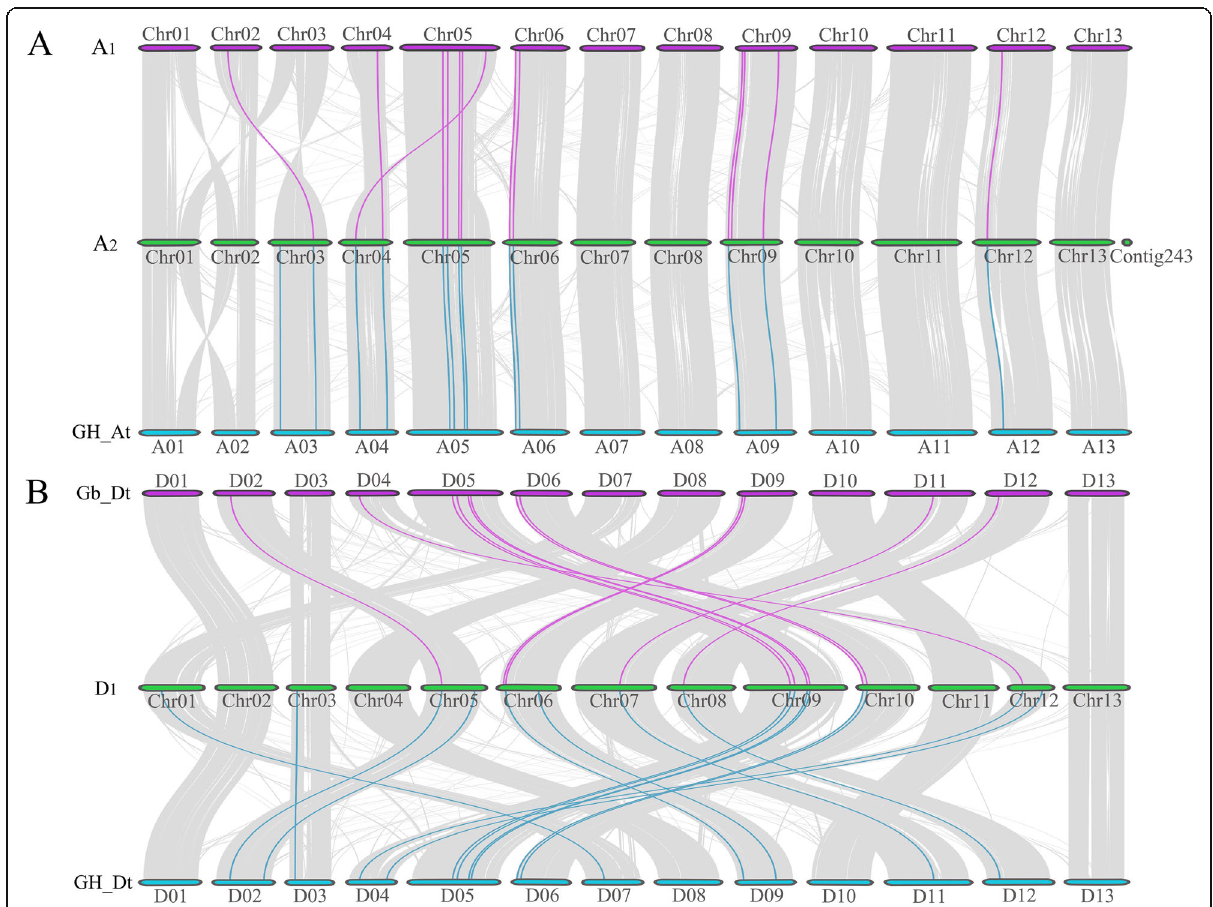
Fig. 3 Distribution and gene duplications of GASA genes. a Synteny analysis of GASA genes between the G. herbaceum (A 1 ), G. arboreum (A 2 ), and G. hirsutum A subgenome (GH_At). b Synteny analysis of GASA genes between G. barbadense D subgenome (Gb_Dt), G. raimondii (D 1 ) and G. hirsutum D subgenome (GH_Dt). Purple lines and blue lines highlight the syntenic GASA gene